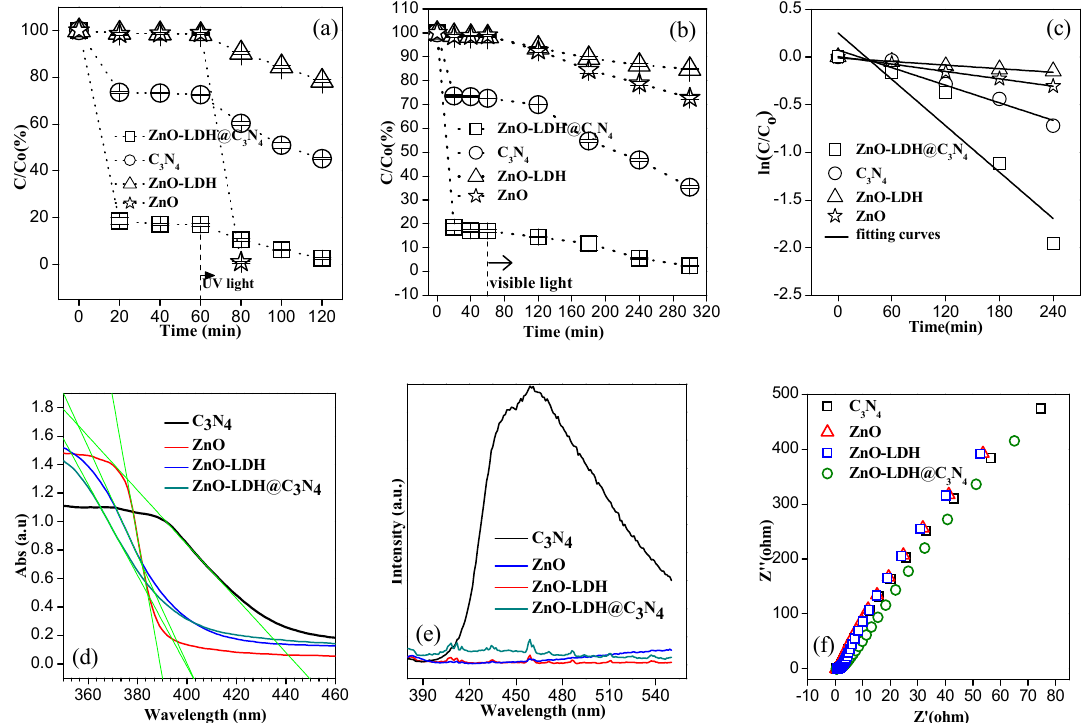
Figure 5. ( a ) Comparison of MB adsorption and photodegradation in water under UV-light over ZnO, ZnO-LDH, g-C 3 N 4 and ZnO-LDH@C 3 N 4 respectively; ( b ) Comparison of MB adsorption and photodegradation in water under visible-light over ZnO, ZnO-LDH, g-C 3 N 4 and ZnO-LDH@C 3 N 4 respectively; ( c ) Kinetic fit for the degradation of MB with the ZnO, ZnO-LDH, g-C 3 N 4 and ZnO-LDH@C 3 N 4 respectively under visible light; ( d ) UV-vis diffuse reflectance spectra of the photocatalysts with corresponding tangent lines; ( e ) Photoluminescence spectra of g-C 3 N 4 , ZnO, ZnO-LDH and ZnO-LDH@C 3 N 4 ; ( f ) Electrochemical impedance spectroscopy of g-C 3 N 4 , ZnO, ZnO-LDH and ZnO-LDH@C 3 N 4 composite.